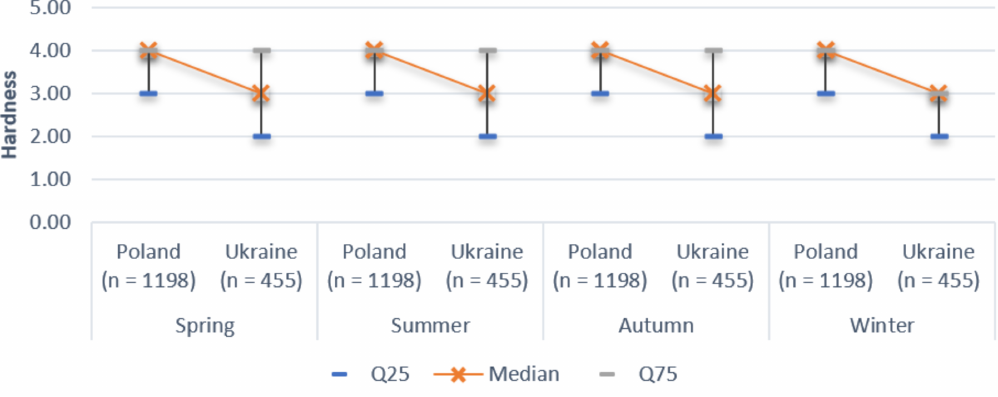
Figure 7. Assessment of tap water hardness during individual periods of the year by groups of respondents from Poland and Ukraine.